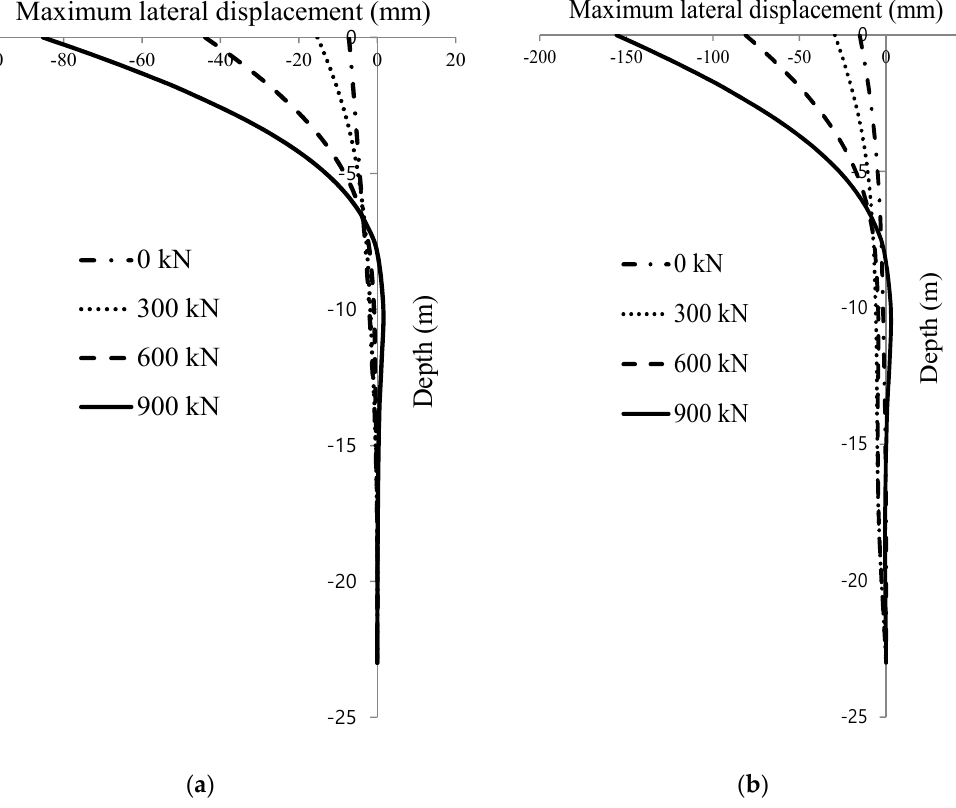
Figure 17. Effect of superstructure weight on lateral displacement of a pile in dry soil: ( a ) Input